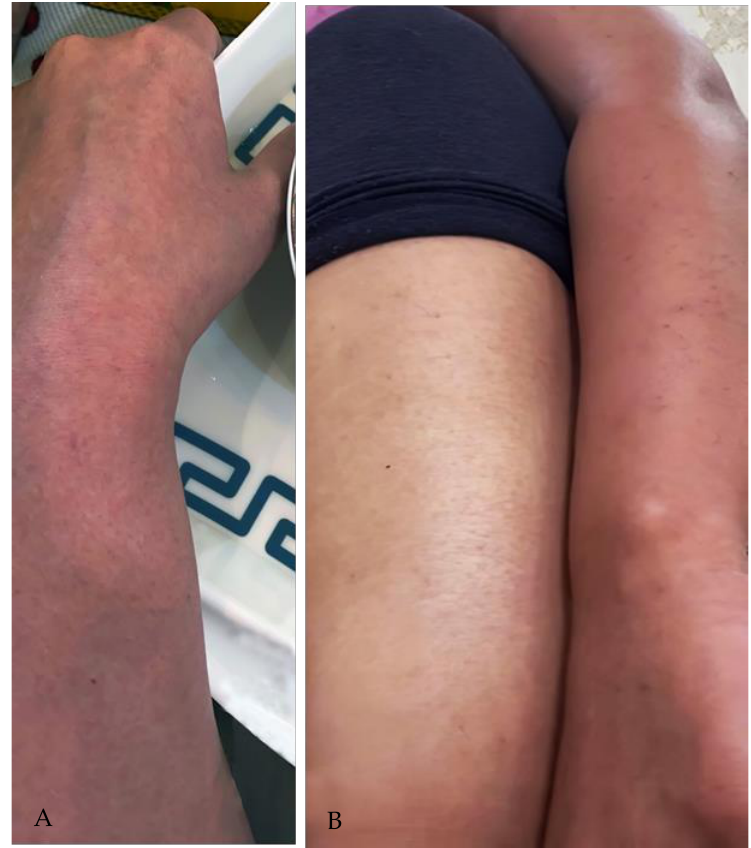
Figure 1. ( A , B ) a non-blanching petechial rash over the Lower and upper limb extremities.